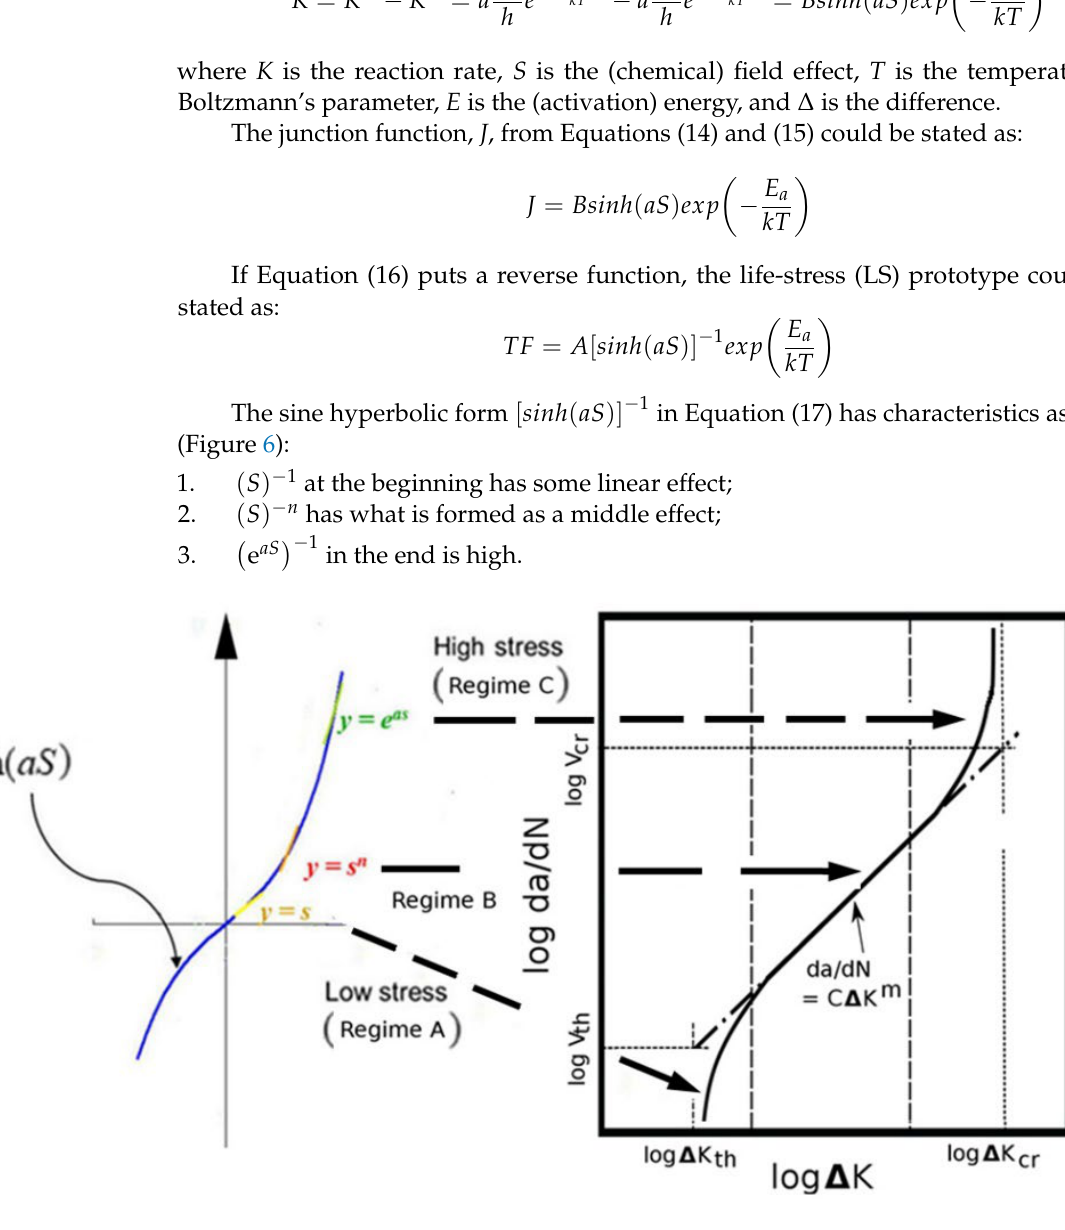
Figure 6. Sine hyperbolic stress expression in contrast to Paris law from a viewpoint of stress span. Because an ALT in the medium range is normally carried out, Equation (17) could be expressed as: